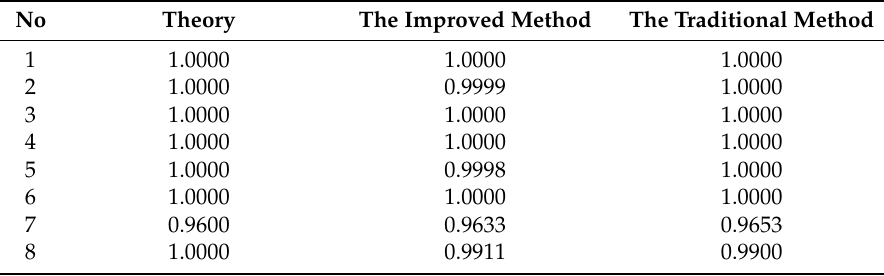
Table 5. Damage identification results with a single smaller damage.